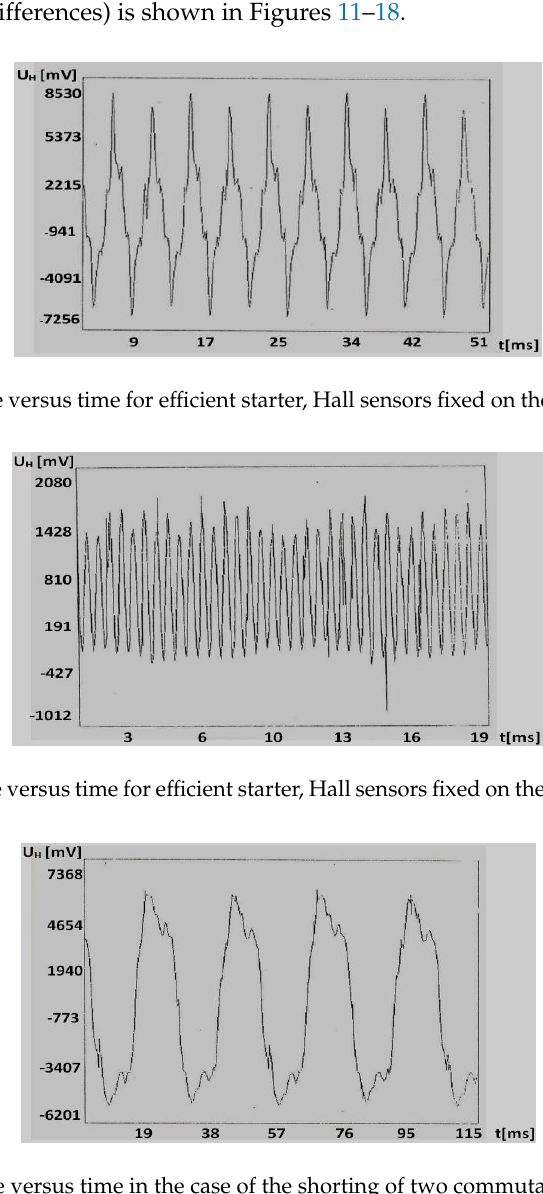
Figure 14. Hall voltage versus time in the case of the shorting of two commutator sectors, Hall sensors fixed on the stator, loaded starter.